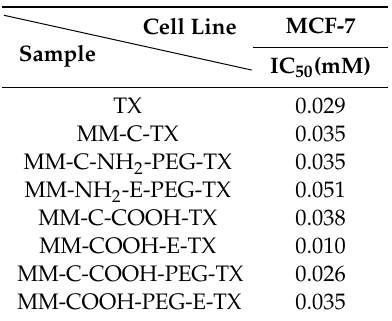
Table 2. Equie ff ective (IC 50 )